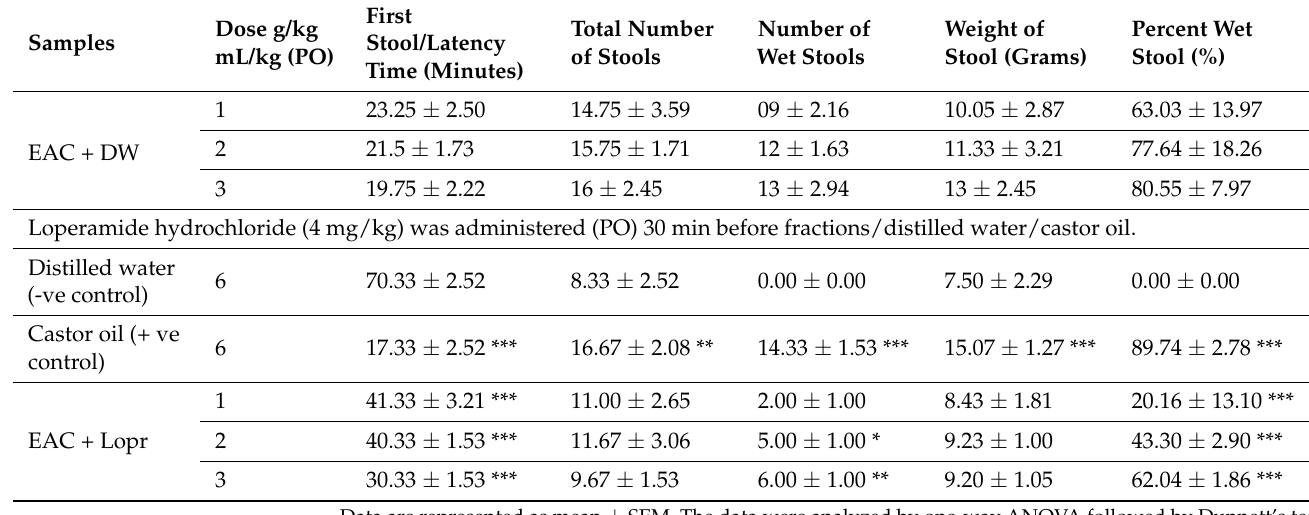
Table 7. Diarrheal/laxative activity of EAC.